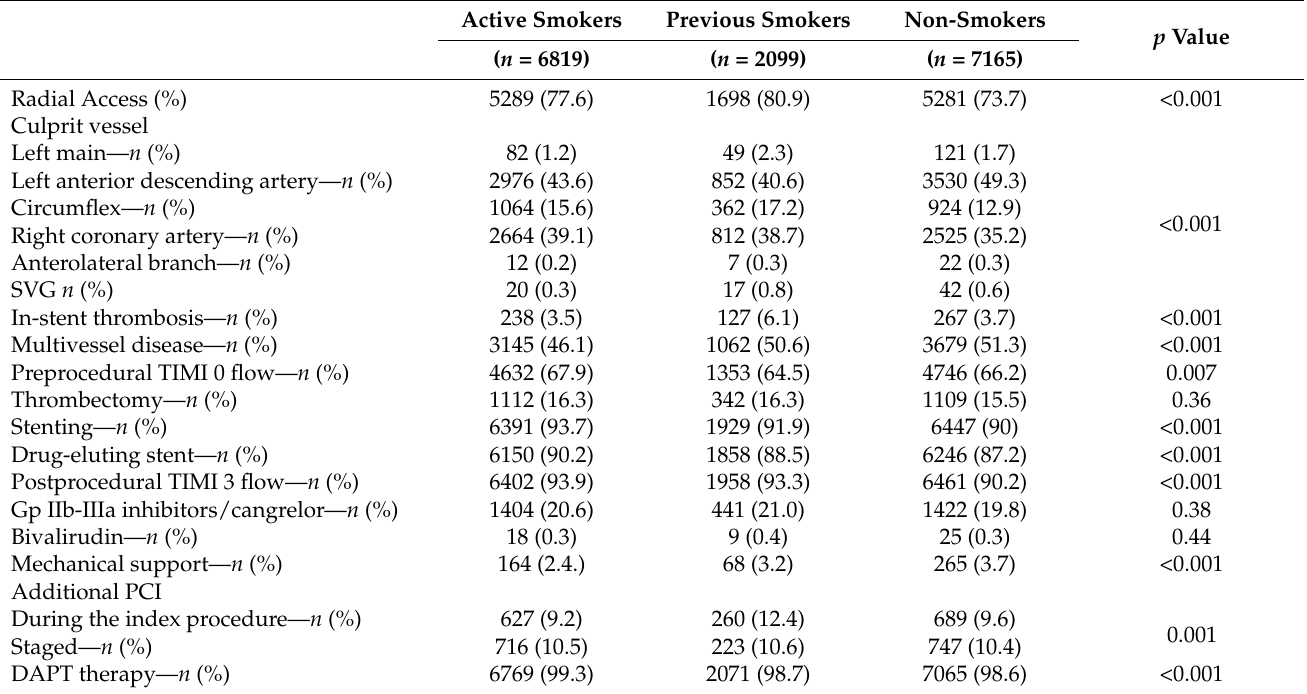
Table 2. Angiographic and procedural